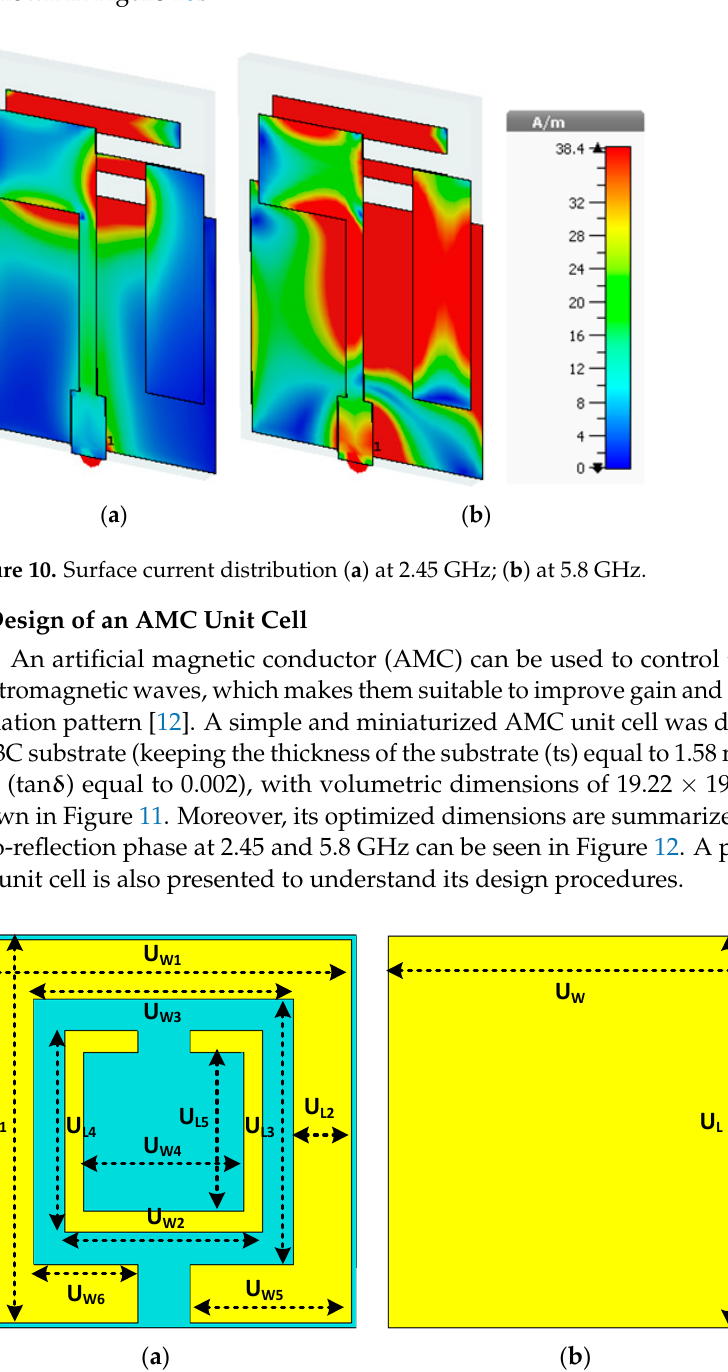
Figure 11. Unit cell dimensions: ( a ) front dimensions, ( b ) back dimensions.